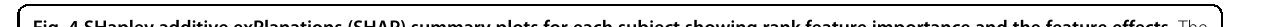
Fig. 4 SHapley additive exPlanations (SHAP) summary plots for each subject showing rank feature importance and the feature effects. The feature importance is depicted by the size of the gray bars that represent mean absolute Shapley values for the top- fi ve features; bar colors simply represent different feature identity. The feature effects are depicted by each colored point on the summary plot which is a Shapley value for a feature and an instance. The position on the y -axis is determined by the feature and on the x -axis by the Shapley value. The color represents the value of the feature from low (blue) to high (pink). Overlapping points are jittered on the y -axis direction, so we get a sense of the distribution of the Shapley values per feature. The features are ordered according to their importance. In most cases, EMA ratings of co-morbid anxiety ( “ anxious ” ) best predicted the depressed state. These plots reveal how each individual had different modalities of data as their top-rank predictors, which can then be leveraged for personalized intervention in future studies. Top variables observed were cumm_step_distance/speed/calories/count that depicted the cumulative step features in the past 12 h; Mean Breathing Time and Consistency that were obtained from the 30-s active stress assessment at each EMA, prev_night_sleep or hours of previous night ’ s sleep; past day sugars/fats/caffeine ; exercise_duration/calories over the past 24 h; heart rate within the 30 min window of the EMA; ppg_std that depicted the HRV in the 15 min window of the EMA and time of day . In some cases, neurocognitive metrics also emerged as top-ranking features, including LD_GL_bias and LD_RareG_diff that respectively represented the bias towards frequent gain vs. loss in the reward task and the preference for rare gain choices when they have greater vs. equal expected value in the reward task; GLbias_dACC/left DLPFC that was the neural activity in the dACC/left DLPFC brain region corresponding to bias for frequent gains vs. losses on the reward task; diff_rareLG_leftDLPFC that was the neural activity in the left DLPFC brain region evoked to choices made on the reward task with a contrast of expected values; gw_leftDLPFC that was the neural activity in the left DLPFC brain region evoked to the Go Wait inhibitory control task; mf_leftDLPFC that was the neural activity in the left DLPFC brain region evoked to the Middle fi sh interference processing task; and ls_leftDLPFC that was the neural activity in the left DLPFC brain region evoked to the Lost Star working memory task.